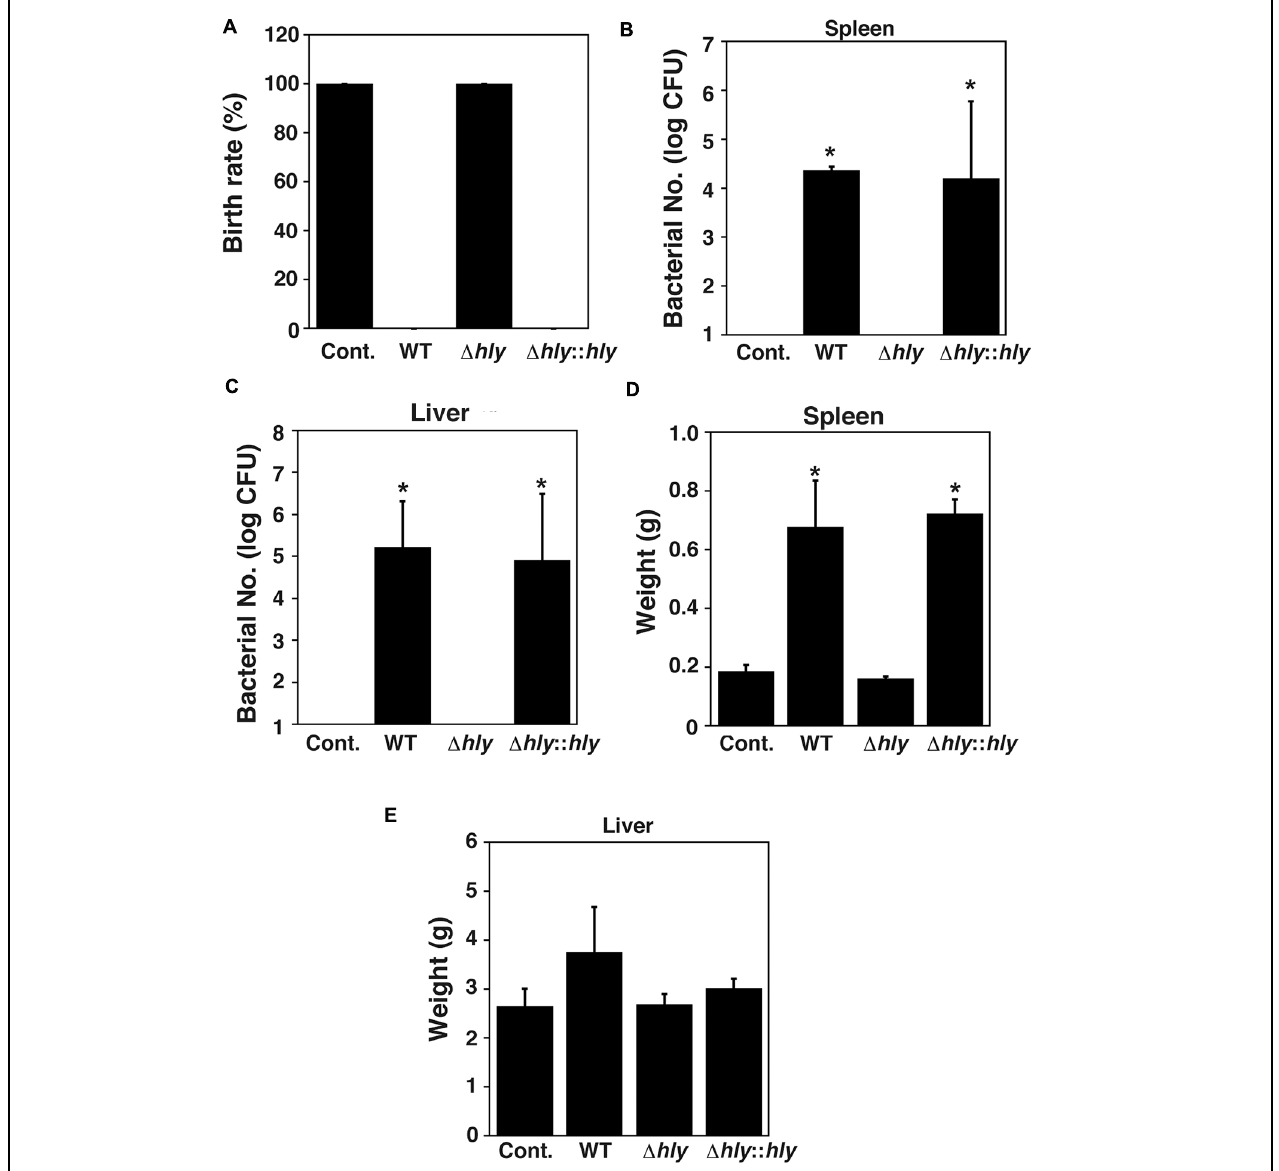
FIGURE 6 | LLO contributes to infection-associated abortion. (A) Birth rate. Groups of three pregnant animals were infected intravenously at 7.5 days of gestation with approximately 2 × 10 4 cells of L. monocytogenes wild-type strain EGD, LLO deletion mutant ( (cid:2) hly ), and LLO-complemented strain ( (cid:2) hly :: hly ). (B,C) Number of bacteria in the spleen (B) and liver (C) of mice infected with the L. monocytogenes strains described above. At 18.5 days of gestation, their spleens and livers were removed and homogenized. The serially diluted tissue homogenates were plated on BHI agar plates and the number of CFU was determined. (D,E) Weights of spleen (D) and liver (E) from mice infected with the L. monocytogenes strains described above. (B–E) All values represent the means and SD ( n = 9). ∗ P < 0.05 compared with Cont. by post hoc Tukey–Kramer